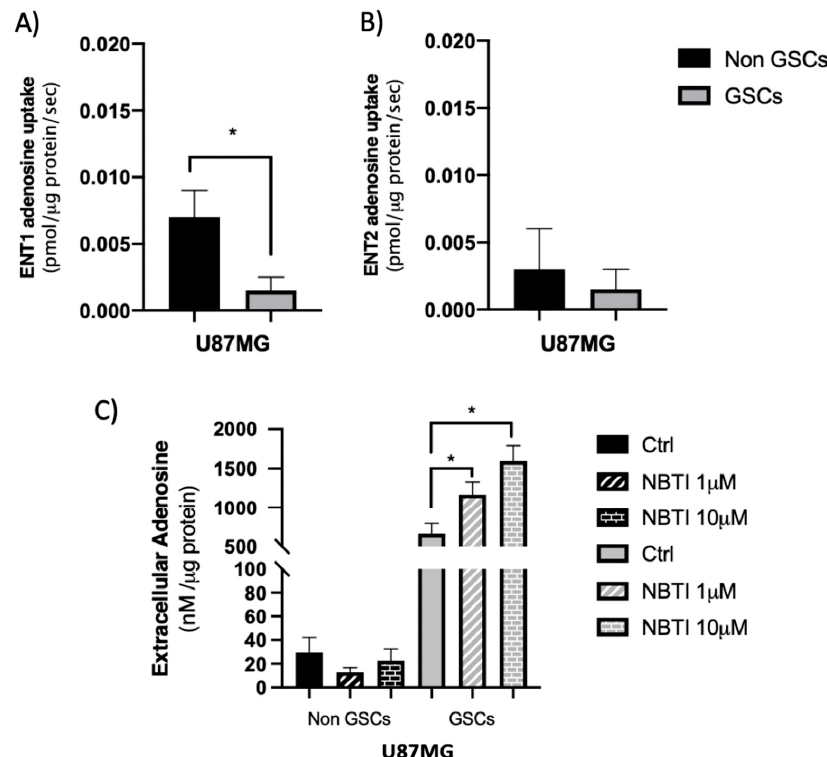
Figure 2. GSCs exhibit lower ENT1 transport activity relative to non-GSCs. U87MG cells were